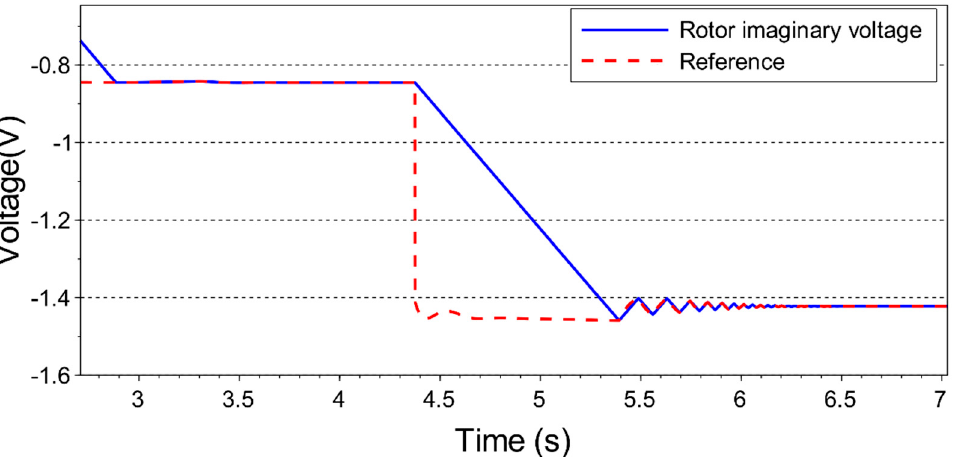
Figure 15. (cid:1848) (cid:3019)(cid:3045) reference update.